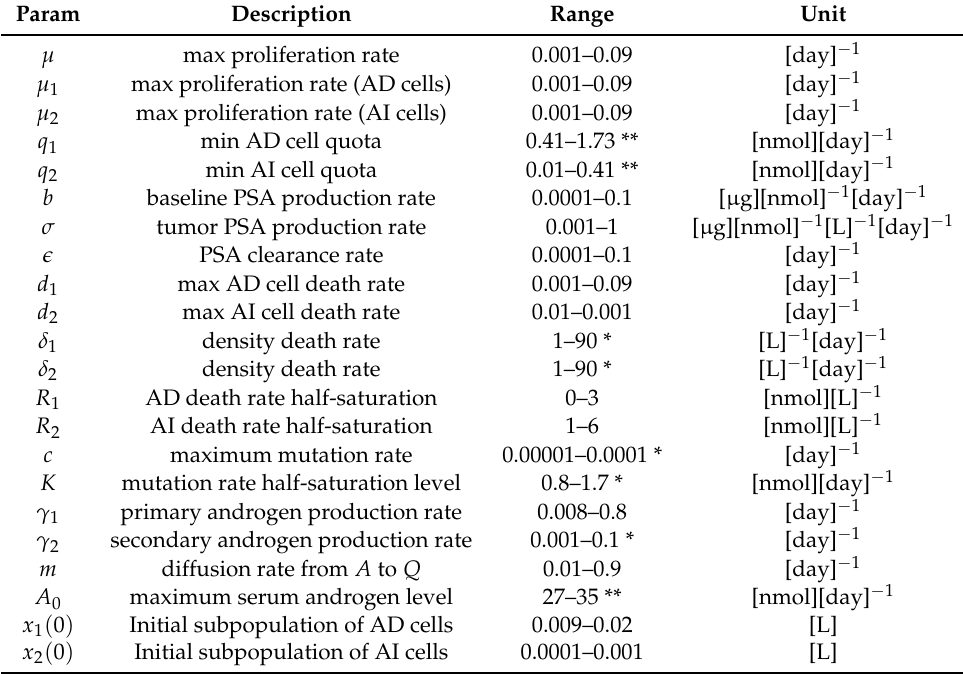
Table 2. Parameter definition and range, established via clinical data and previous computational work. Note that the parameters with an asterisk next to their fitting range are fixed in the new model, e.g., c , K , δ 1 , δ 2 , and γ 2 are fixed at 0.00015, 1, 5, 5, and 0, respectively. The ranges of parameters